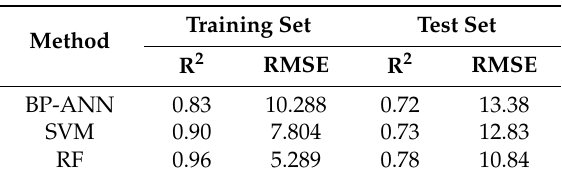
Table 8. Accuracy assessment of the different multi-factor non-parametric regression models using the 10-fold cross-validation method.